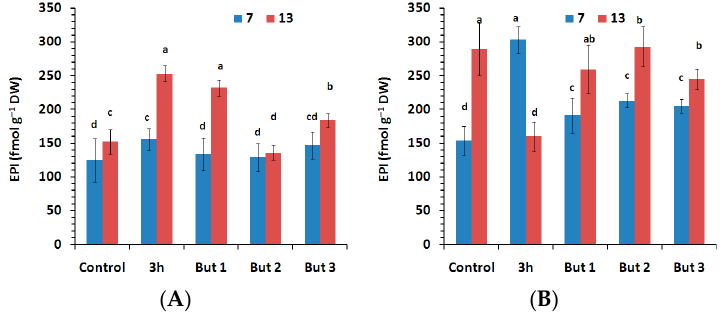
Figure 9. Content of EPI—24-epibrassinolide measured in the seeds of two L. angustifolius cultivars (Lazur—( A ); Sethes Fruehe Rote—( B )) germinated at 7 °C or 13 °C in water (control), butenolide or hydroprimed in water for 3 h at 20 °C. But 1, But 2, But 3: 10 − 6 M, 10 − 5 M, 10 − 4 M butenolide concentrations. Different letters over error bars (±SE; n = 3) indicate significant differences (Duncan’s multiple range test, p < 0.05).